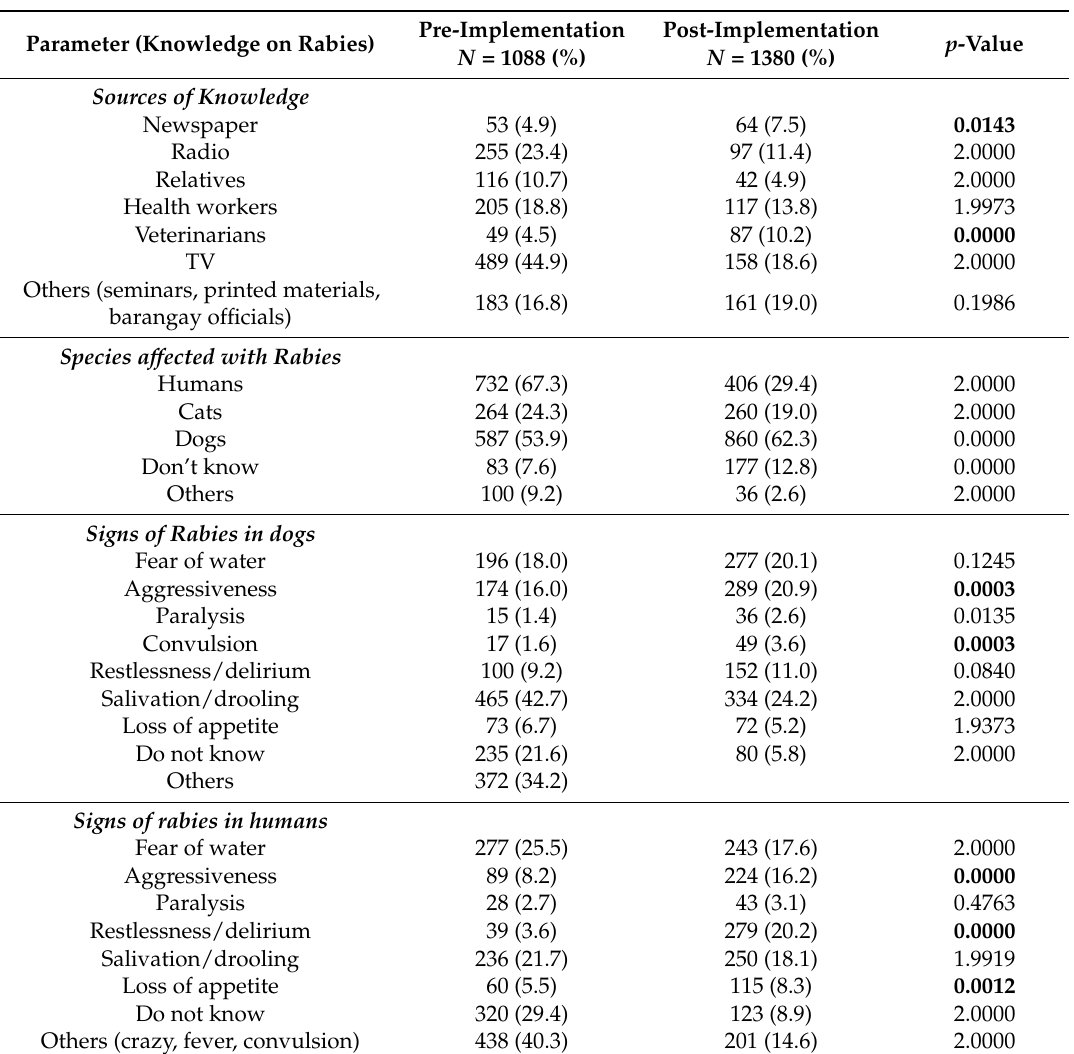
Table 2. Knowledge on